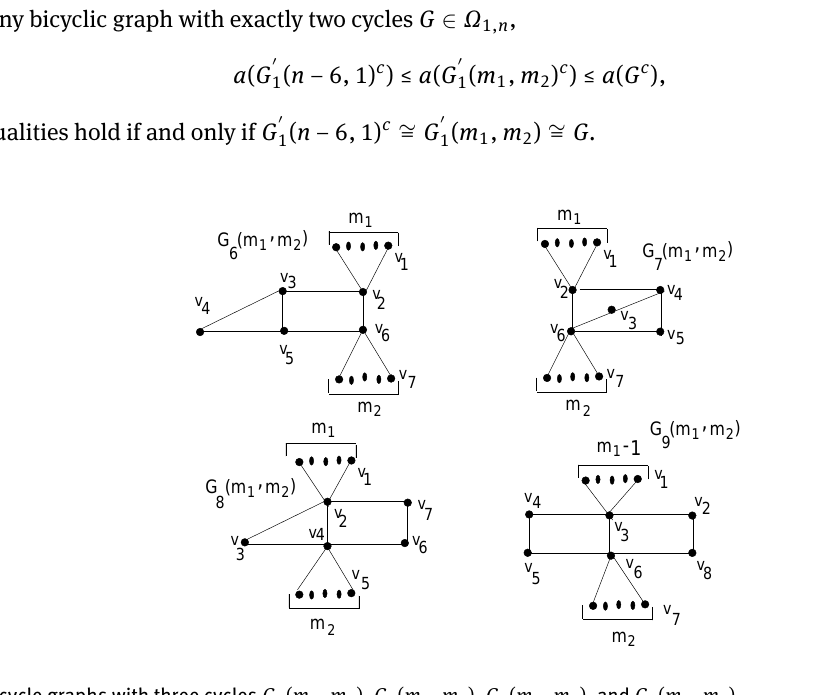
Figure 2: Bicycle graphs with three cycles G 6 ( m 1 , m 2 ) , G 7 ( m 1 , m 2 ) , G 8 ( m 1 , m 2 ) , and G 9 ( m 1 , m 2 ) .